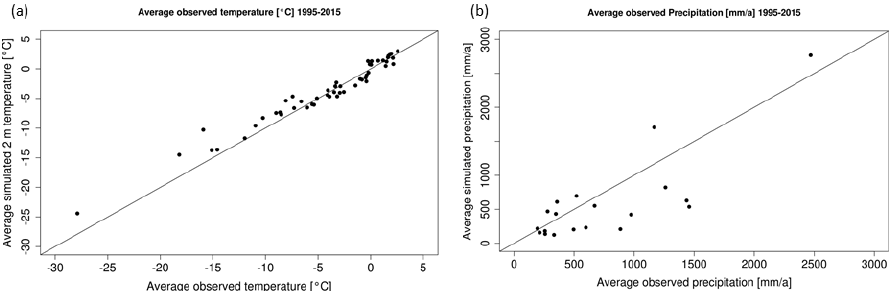
Figure 2. Simulated yearly mean (a) 2m temperatures and (b) precipitation sums of a standard COSMO simulation, driven with ERA- Interim, for Greenland over the period 1995–2015 compared to DMI observations. The solid black line is the 1 : 1 line in (a, b) .